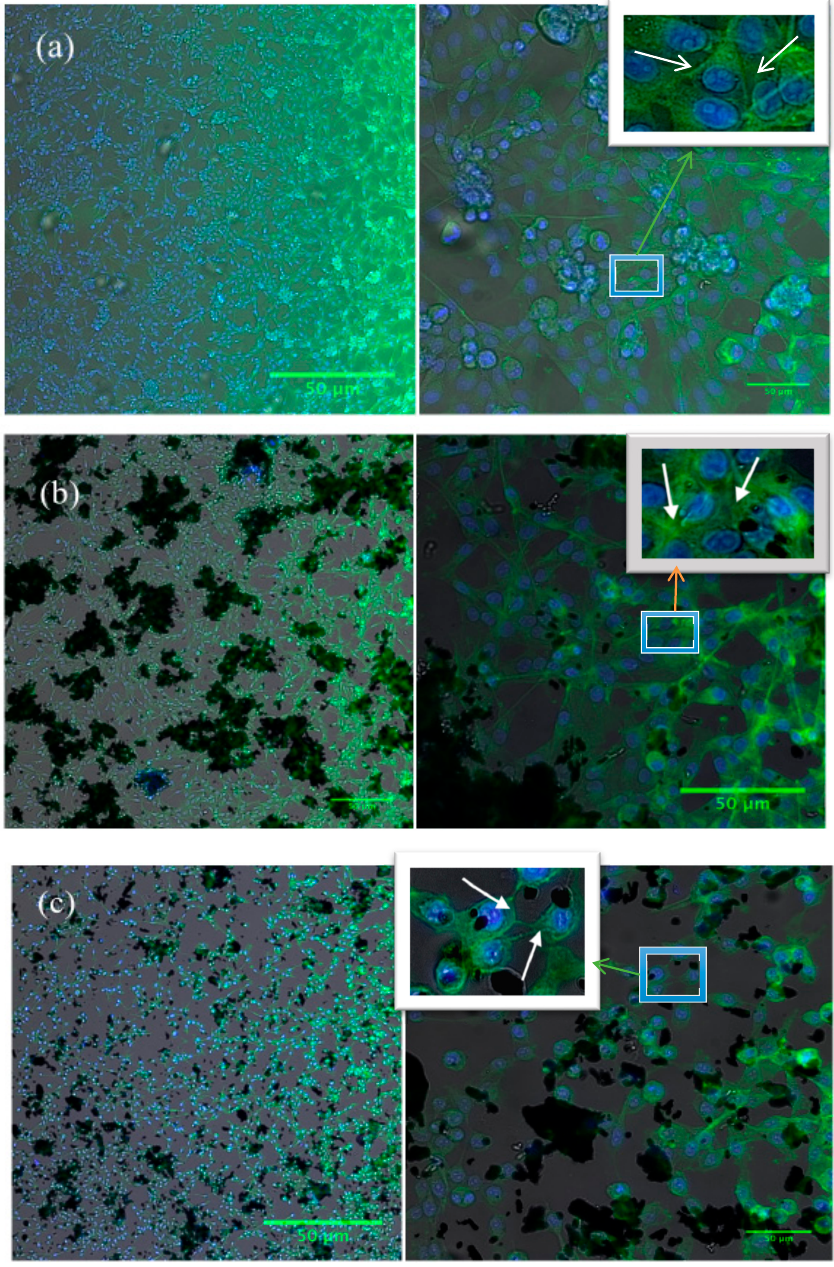
Figure 7. ( a ) Fluorescence images of Control, ( b ) Fluorescence images of HeLa cells treated with GO-Fe 3 O 4 non-heated (not subjected to AC magnetic field) and ( c ) Fluorescence images of HeLa cells treated with GO-Fe 3 O 4 heated (subjected to AC magnetic field). The blue box shows the portion of the image selected for magnification while the white box shows magnified view of the selected portion. The green ( a ), ( c ) and orange ( b ) arrows point to the magnified view while the white arrows point to the cytoskeleton changes.